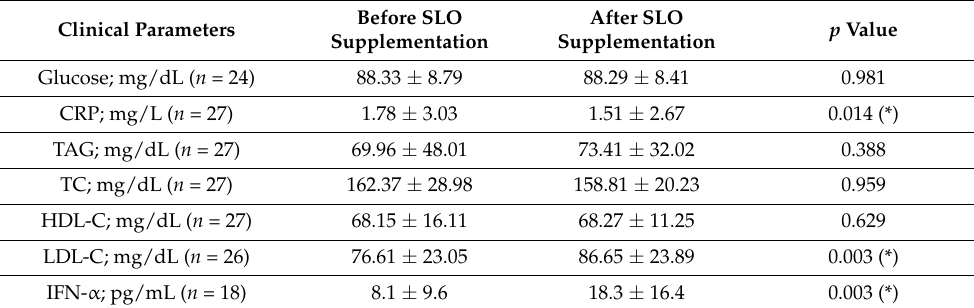
Table 1. Measurements of serum biochemical parameters in study participants before and after 6 weeks of SLO supplementation. ( n ) value represents the number of subjects in which the analysis was performed. Before SLO After SLO p Clinical Parameters Supplementation Supplementation